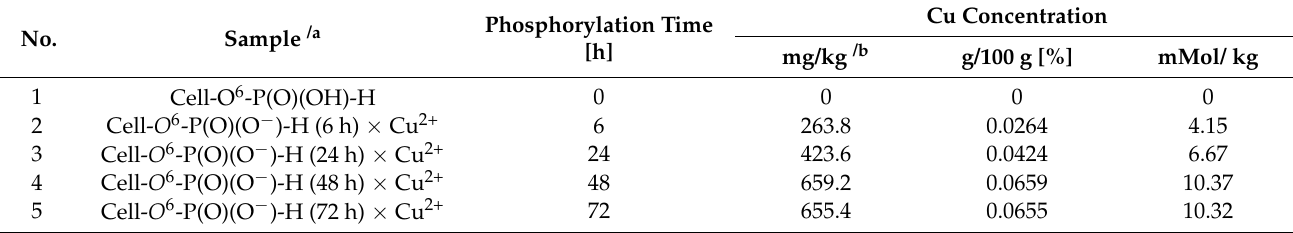
Table 9. Copper content in Cell- O 6 -P(O)(OH)-H samples and their copper complexes Cell- O 6 -P(O)(O − )-H × Cu 2+